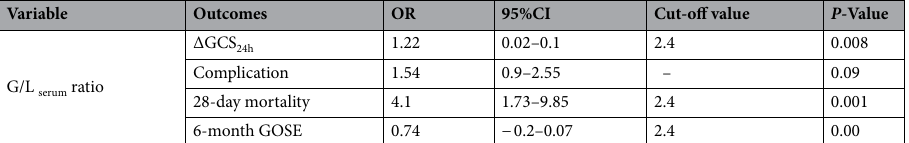
Table 2. Correlation analysis between the G/L serum and the outcomes. G/L serum: glucose/lactate; ΔGCS 24h : difference of GCS scores before the surgery and after 24 h of ICU admission; OR:odd ratio.